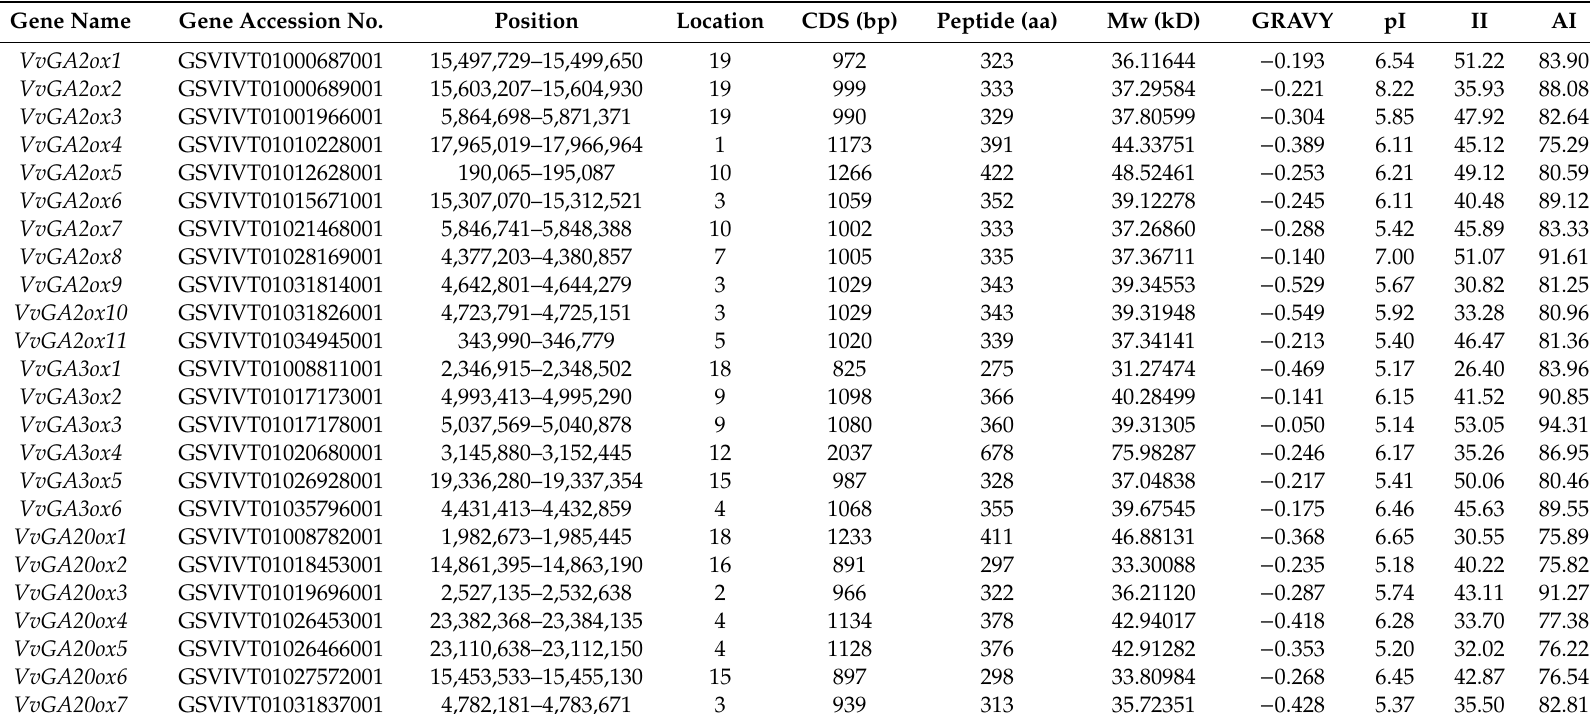
Table 1. The characteristic of